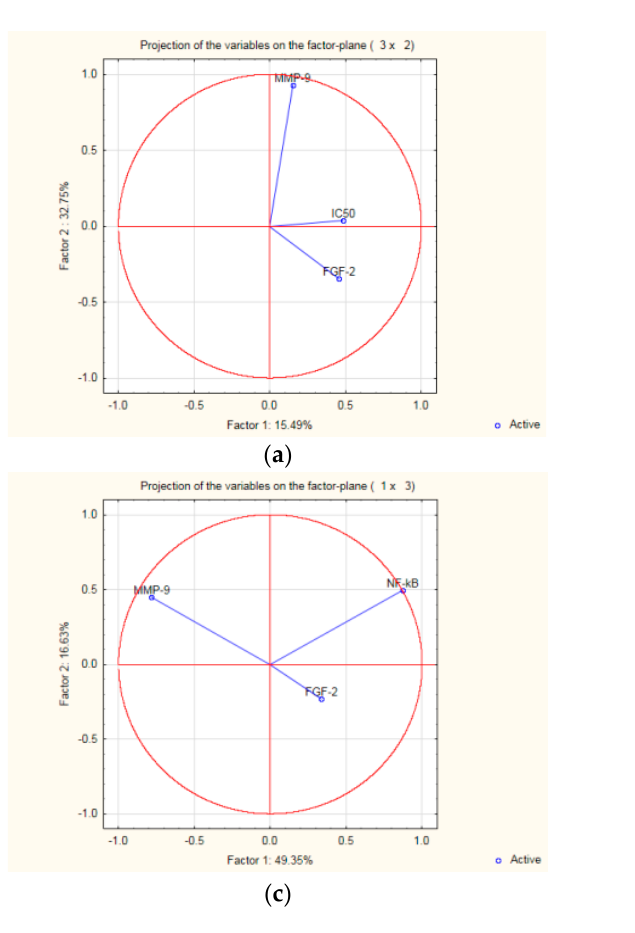
Figure 7 (a-d). Principal component analysis of the relationship between IC 50 values, NF- κ B tran- scription factor activation, FGF-2, and MMP-9 levels in A2780 cells treated with 1 , 2 , 3, and 4 .